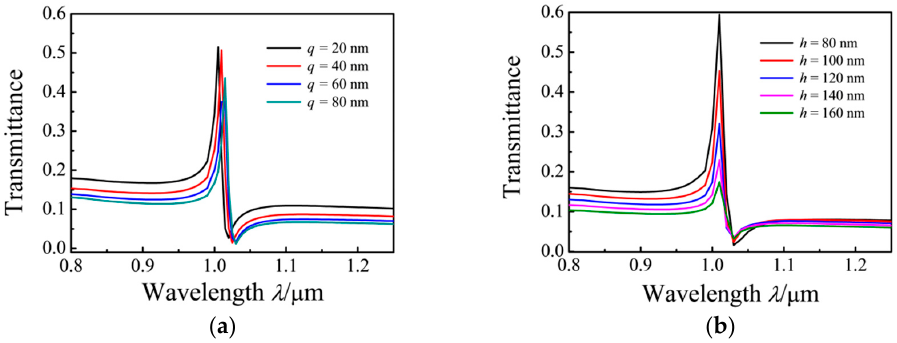
Figure 5. Transmission spectra of the MIM waveguides coupled with ring and rectangular cavities with ( a ) changing q ( h = 100 nm) and ( b ) changing h of the rectangular resonator. The radius of the ring cavity was changed to study its effect on the transmission